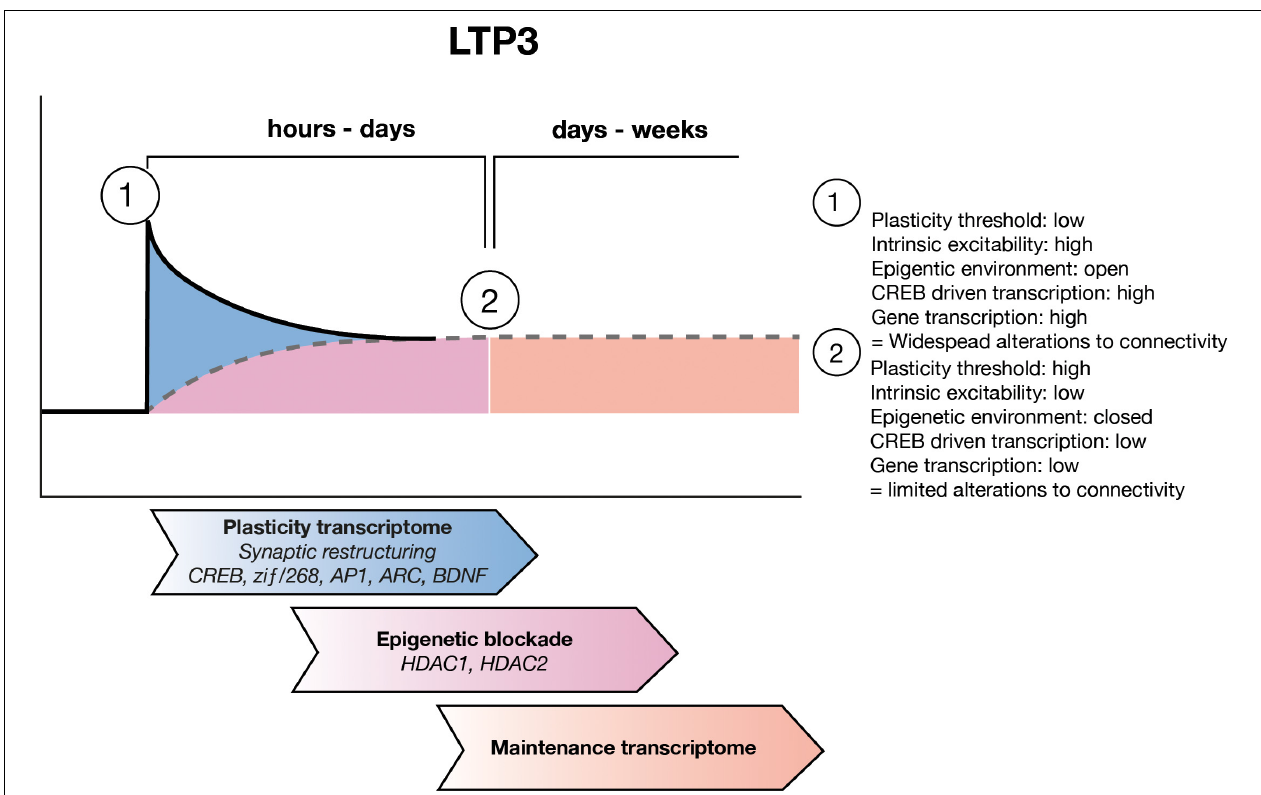
FIGURE 2 | LTP maintenance hypothesis. Upon LTP induction, the threshold for plastic adaptations throughout the cell is low and as such CREB driven gene expression allows for widespread structural and functional modifications to synapses and to the intrinsic excitability of the cell. Over the subsequent hours to days, ongoing waves of gene expression allow for refining of the engram circuitry, through pruning of unwanted inputs. During this time the maintenance transcriptome develops which includes epigenetic negative regulators of gene expression such as HDAC1 and HDAC2 as well as other negative regulators of plasticity. Eventually the maintenance transcriptome sets a new, higher threshold for plasticity which allows for the connectivity of the engram to be